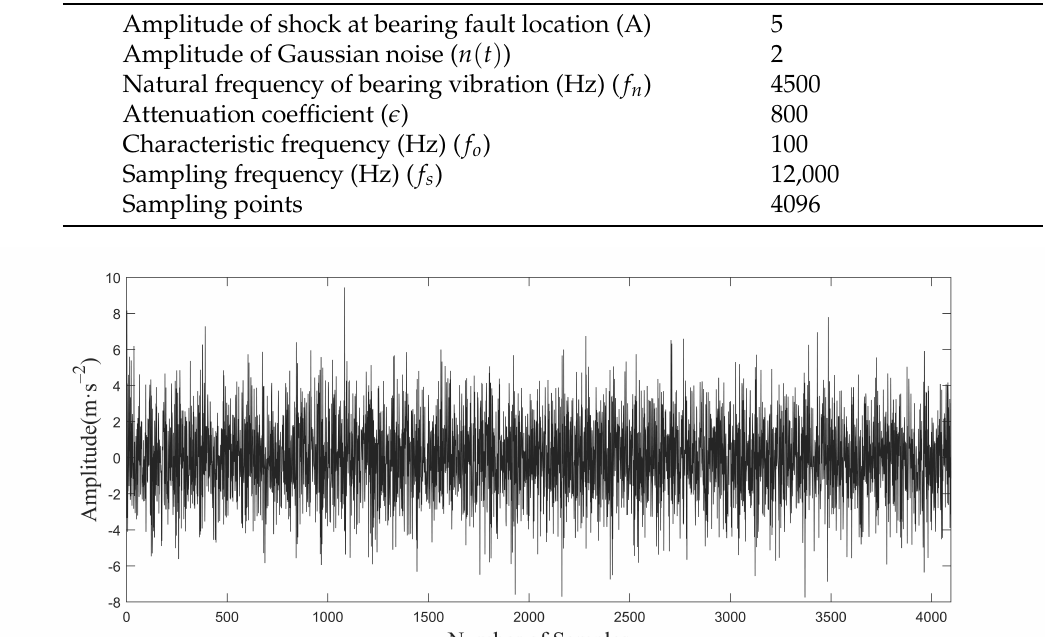
Figure 4. Bearing outer ring fault—simulated signal Y( t ).